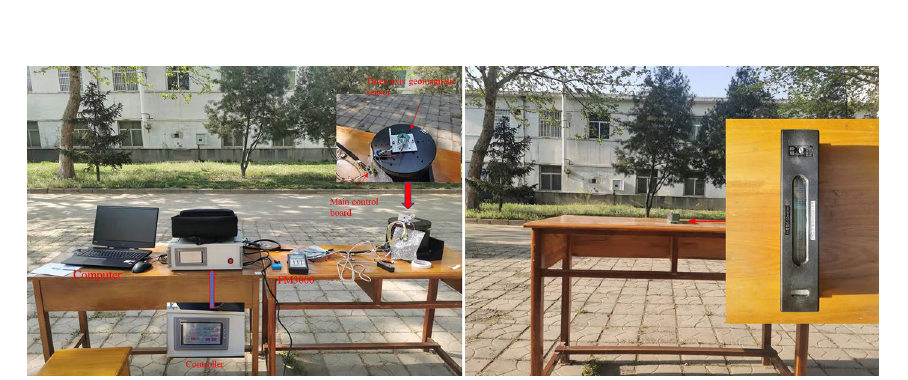
Fig. 13 Experimental environment